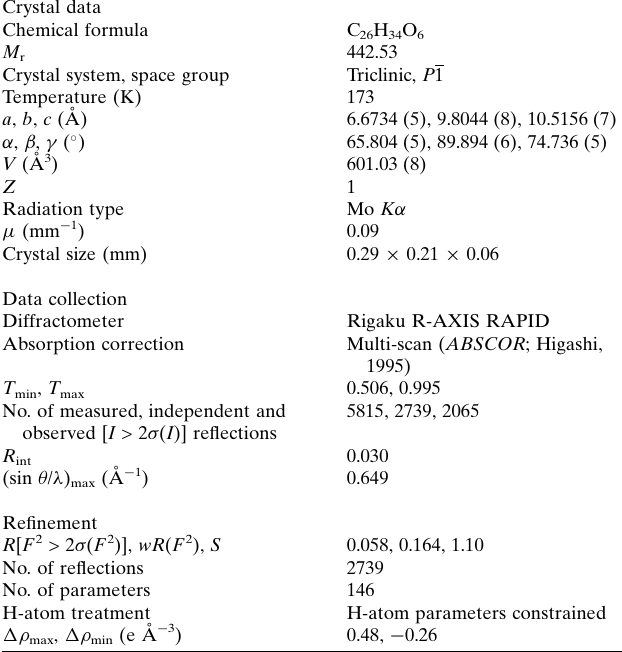
Table 2 Experimental